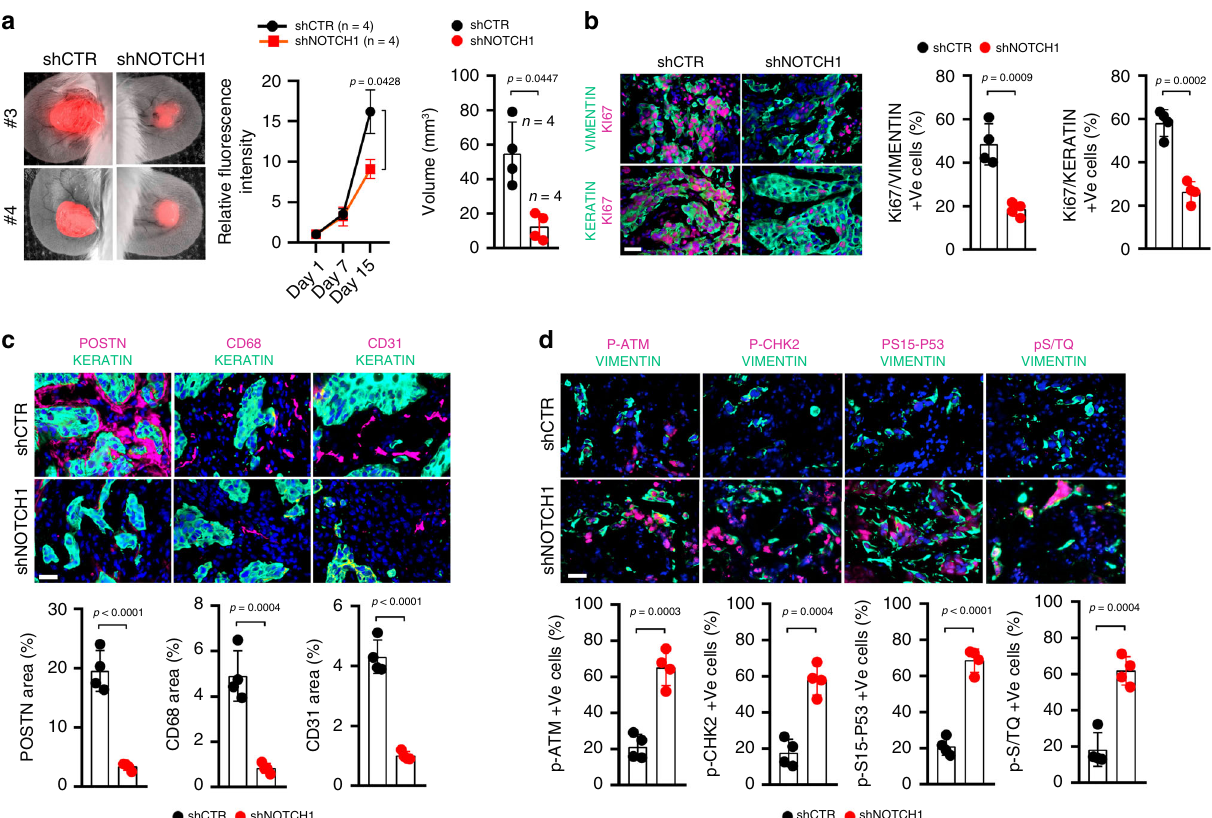
Fig. 9 NOTCH1 silencing impairs cancer/stromal cell expansion in vivo. a DsRed2-expressing SCC13 cells were admixed with CAFs (CAF14) plus/minus NOTCH1 silencing followed by parallel ear injections into NOD/SCID mice. Shown are images of two ear pairs 15 days after injection, quanti fi cation of red fl uorescence signal (normalized to day 1 after injection) corresponding to SCC13 cell expansion, and tumor volumes ( V = (length × width 2 ) × 0.5). Statistical analysis of fl uorescence intensity values over time course of the experiment was calculated by Two-way ANOVA, * p < 0.05. Tumor volume values are indicated as dots with mean ± s.d. two-tailed unpaired t -test, * p < 0.05. n (shCTR ear lesion) = 4, n (shNOTCH1 ear lesion) = 4. b Immuno fl uorescence analysis of ear lesions with antibodies against Ki67 (magenta) and human-speci fi c VIMENTIN or KERATIN (cyan) for cell identi fi cation. Scale bar, 50 μ m. Values for each ear lesion are indicated as dots with mean ± s.d. two-tailed unpaired t -test, *** p < 0.001. n (mice) = 4, n (shCTR ear lesion) = 4, n (sh NOTCH1 ear lesion) = 4. Results from an independent experiment with a second CAF strain (CAF16) are in Supplementary Fig. 6a. c Immuno fl uorescence analysis of ear lesions with antibodies against the CAF marker PERIOSTIN (POSTN), macrophage (CD68), and endothelial (CD31) markers (magenta) with KERATIN (cyan). Scale bar, 50 μ m. Values for each ear lesion are indicated as dots with mean ± s.d. two-tailed unpaired t -test, *** p < 0.001, **** p < 0.0001. n (shCTR ear lesion) = 4, n (sh NOTCH1 ear lesion) = 4. Results from an independent experiment with a second CAF strain (CAF16) are in Supplementary Fig. 6a. d Immuno fl uorescence analysis of ear lesions with antibodies against the indicated proteins (magenta) together with human-speci fi c anti-VIMENTIN antibodies for CAF identi fi cation (cyan). Scale bar, 50 μ m. Values for each ear lesion are indicated as dots with mean ± s.d. two-tailed unpaired t -test, *** p < 0.001, **** p < 0.0001. n (shCTR ear lesion) = 4, n (sh NOTCH1 ear lesion)